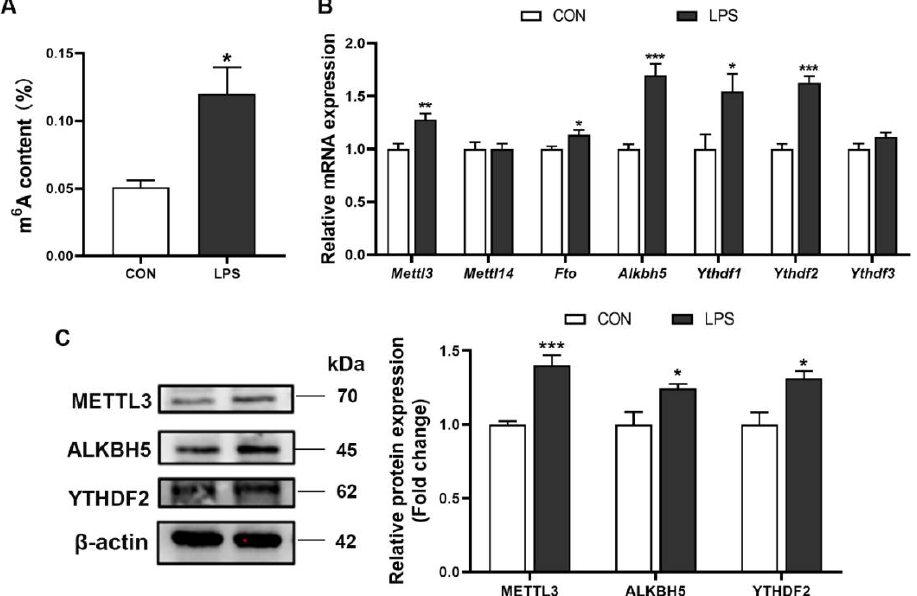
Figure 3. The abundance of m 6 A RNA methylation in the liver of piglets. ( A ) The total m 6 A level was determined by ELISA. ( B ) The mRNA expression of genes related to m 6 A modification were measured by RT-qPCR. ( C ) Hepatic protein levels of METTL3, ALKBH5, and YTHDF2 were evaluated by western blot, and quantification of image density was conducted by ImageJ software. n = 4 − 6 per group. Results are presented as means with SEM represented by a vertical bar; * represents significant differences between the CON group and the LPS group; * p < 0.05, ** p < 0.01, *** p < 0.001.